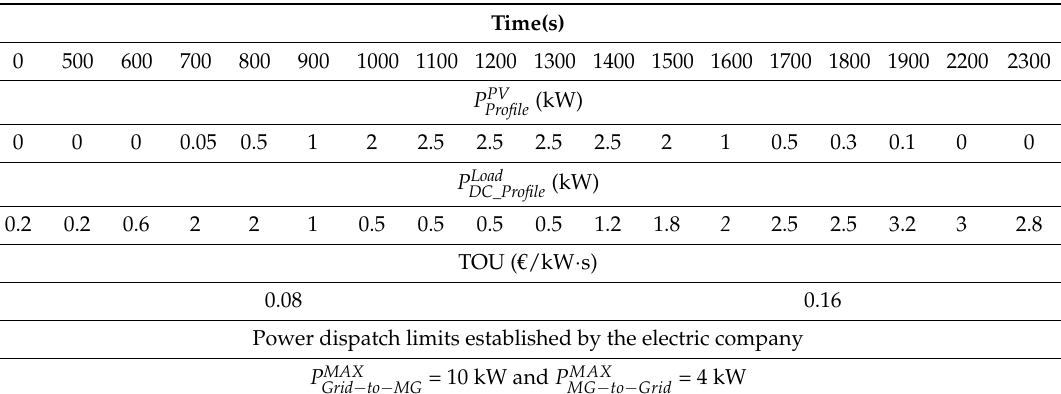
Table 8. Reference profiles sent to the MGCC for the power dispatch planning in the